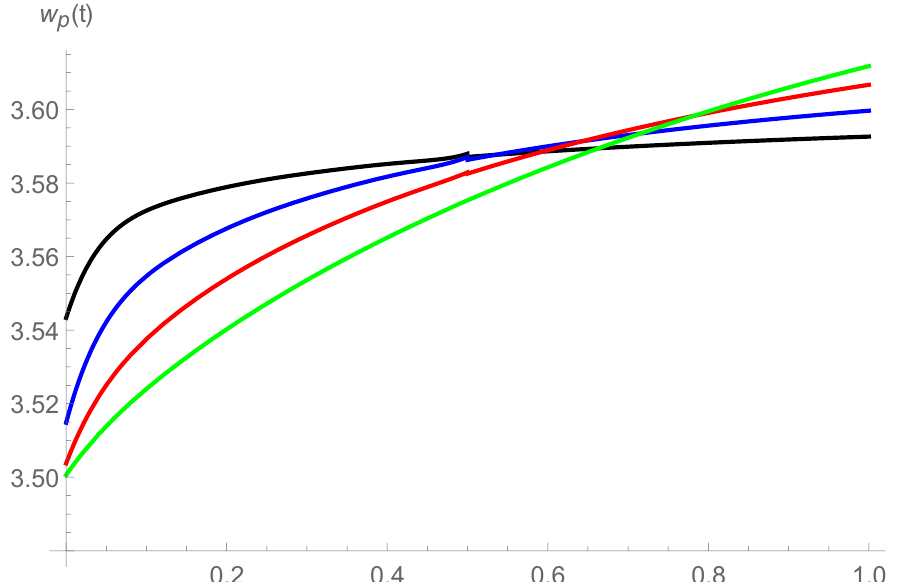
Figure 11. The effect of υ on the distribution of r p ( t ) . Black: υ = 0.2, Blue: υ = 0.4, Red: υ = 0.6, Green: υ = 0.8.